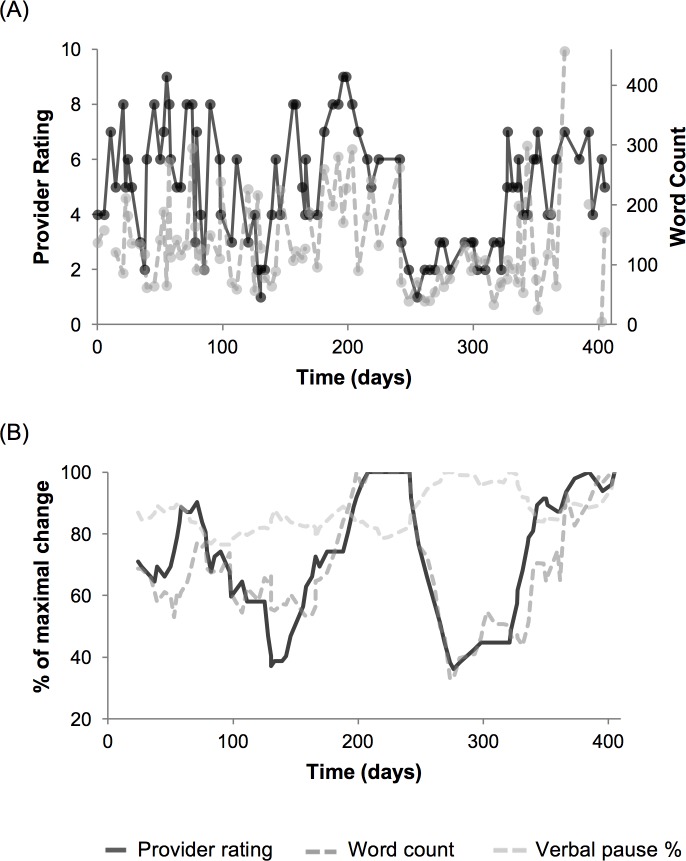
Covariance of speech features and clinical state over time.(A) An example of clinical state (provider global assessment rating, black line) transitions within an individual patient over time compared to the individual’s highest performing linguistic feature (word count per speech sample, dotted grey line) for each call to the MCC system. (B) Increased correlations between clinical state and speech features over time highlighted through percent of maximal change of 8-period moving averages for provider rating (black line), word count (dotted grey line), and verbal pause percent (dotted light grey line) for the same patient and period.